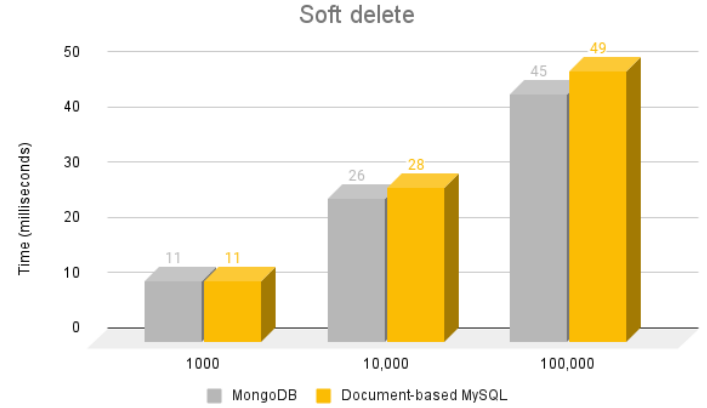
Figure 9. Execution times for soft delete operation.